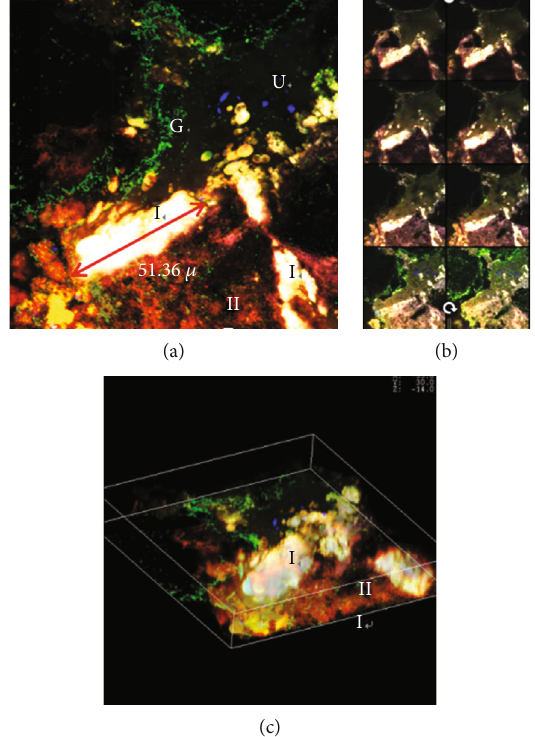
Figure 6: Laser confocal scanning image of di ff erent components of crude oil. (a) Laser confocal scanning image of oily sheet. (b) Series of images of the z -axis layered scanning in the same fi eld of view. (c) 45 ° 3D reconstructed image of the same fi eld of